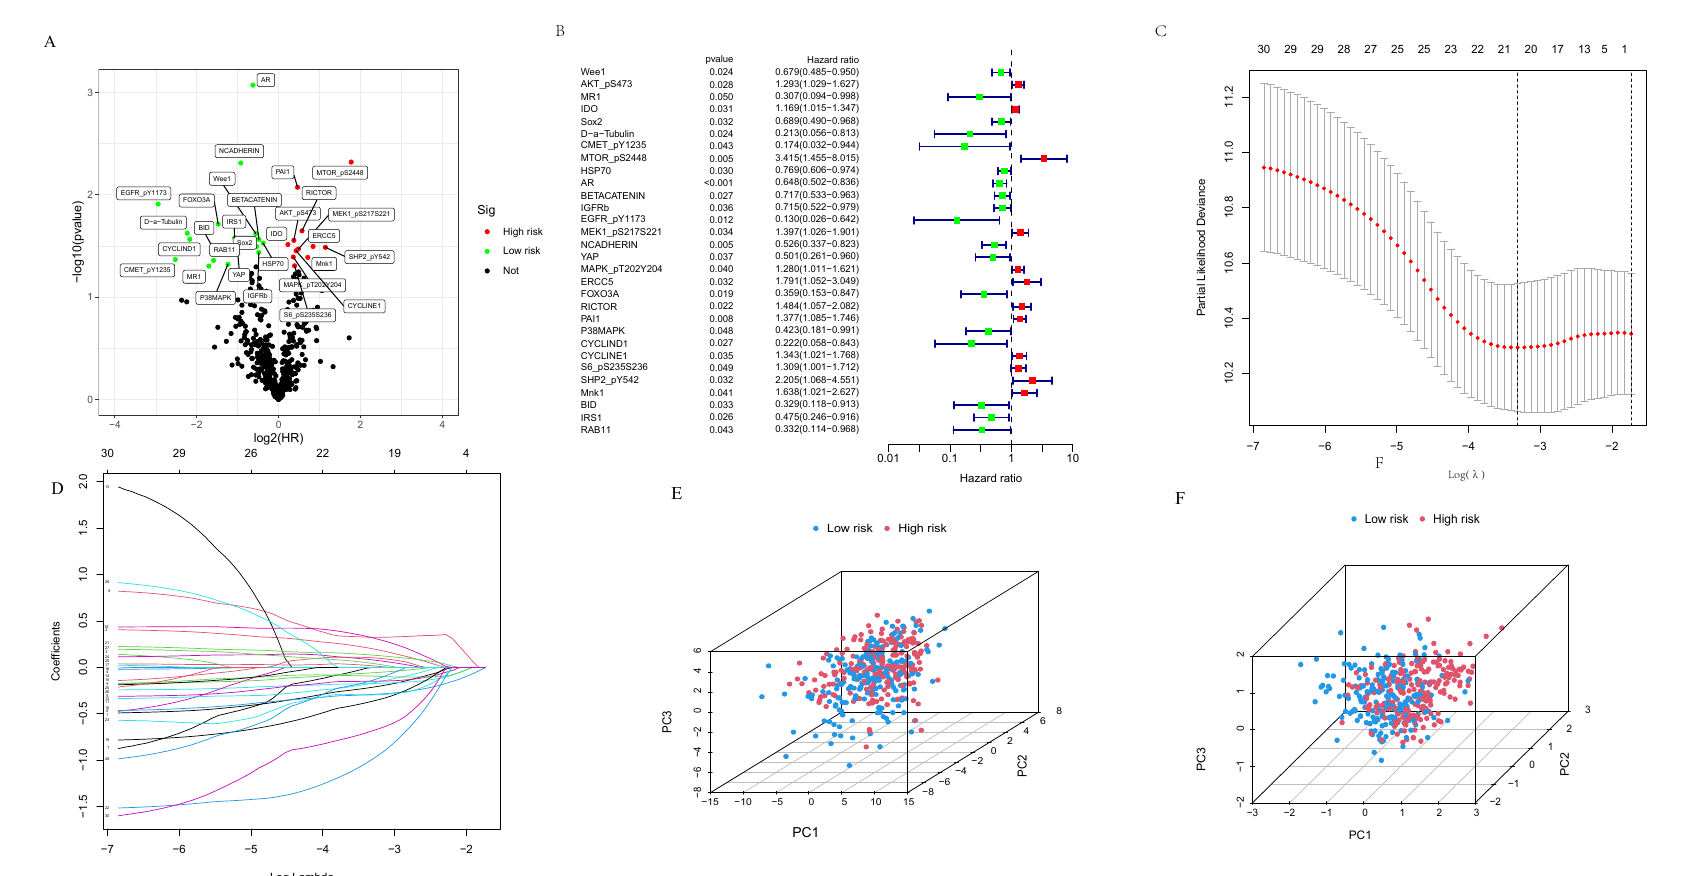
Figure 1. Identification of proteins with prognostic relevance in ovarian cancer. ( A ) A volcano plot was created for the prognosis of differential proteins via univariate Cox regression analyses. The green points show the 18 low-risk proteins, and the red points illustrate the 12 high-risk proteins. ( B ) A forest plot for each prognostic factor was created. The green show the low-risk proteins, and the red illustrate the high-risk proteins. ( C ) The deviance profiles of the LASSO regressions. ( D ) The coefficient profiles of the LASSO regressions. Diverse hues of lines signif distinct gene. ( E ) Analysis of all proteins using PCA. The blue show the low-risk proteins, and the red illustrate the high-risk proteins. ( F ) Analysis of prognostic proteins using PCA. The blue show the low-risk proteins, and the red illustrate the high-risk